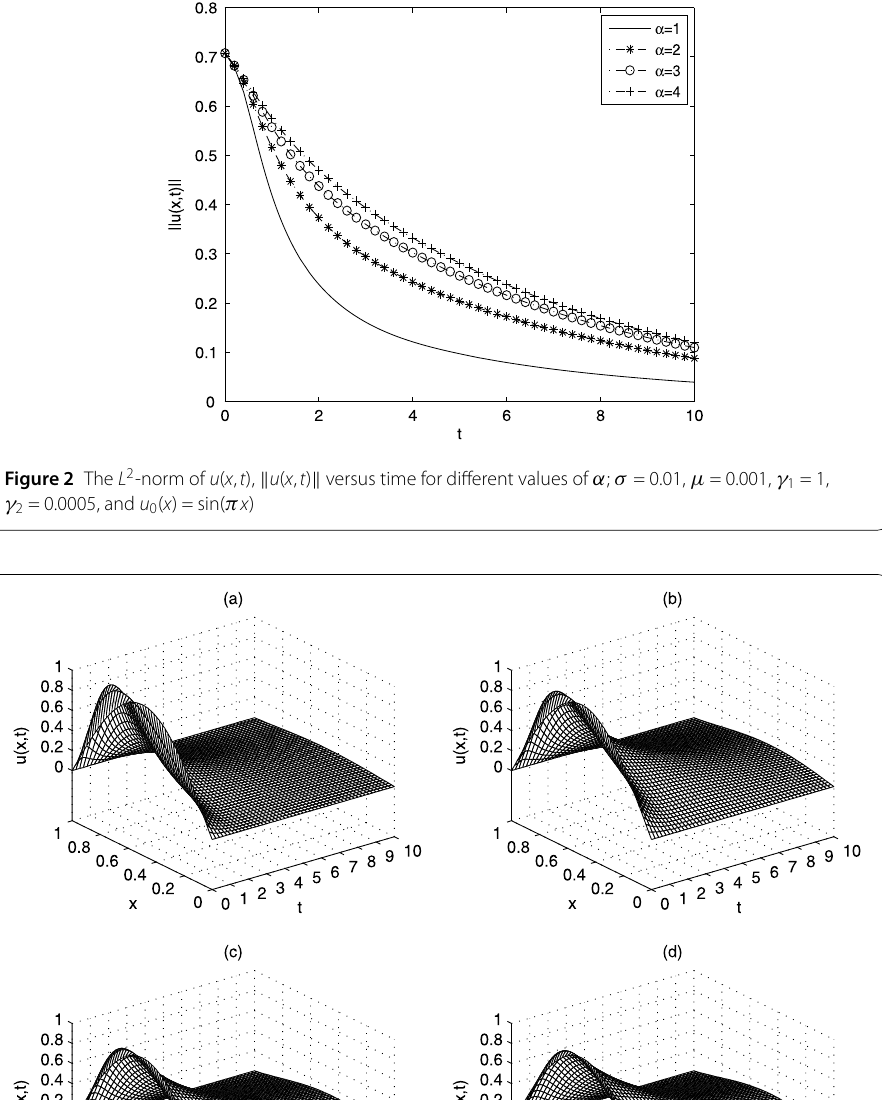
SOL Multiphysics software, the solutions are provided for several values of α . These values are 1, 2, 3, and